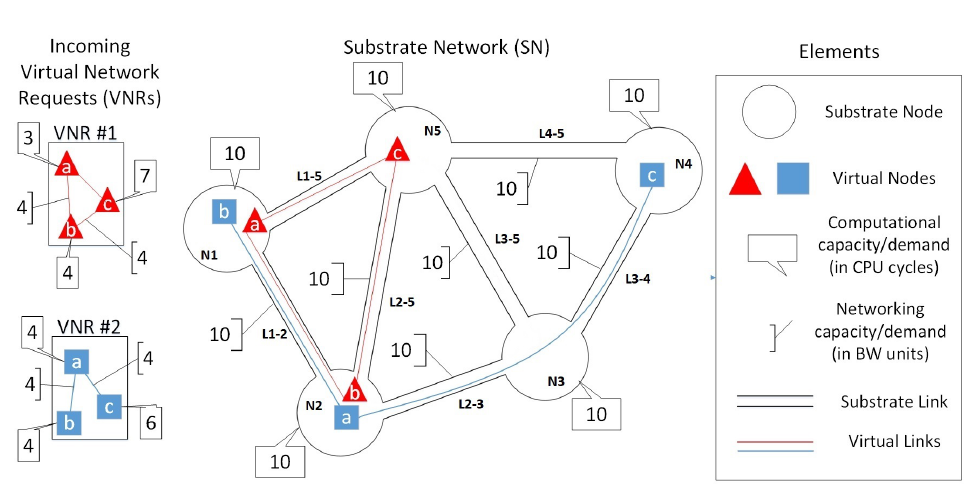
Figure 2. Visualization of VNR